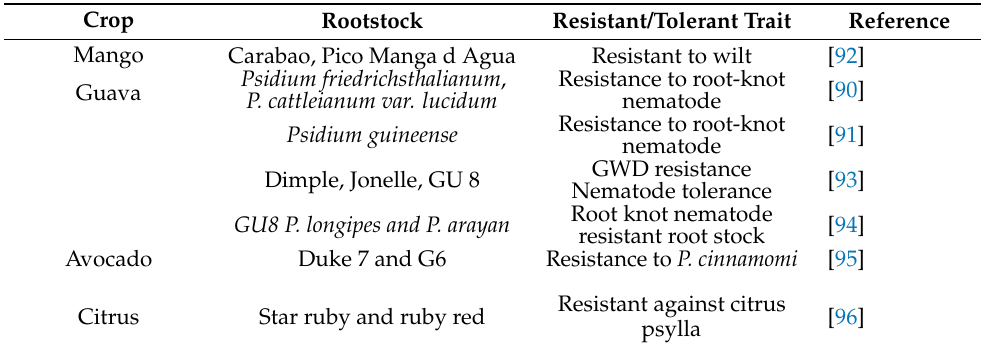
Table 4. Details of rootstock to mitigate biotic stresses in fruit crops. Crop Rootstock Resistant/Tolerant Trait Reference Mango Resistant to wilt [92] Psidium friedrichsthalianum , Resistance to root-knot [90] P. cattleianum var. lucidum nematode Resistance to root-knot Psidium guineense [91] nematode GWD resistance Dimple, Jonelle, GU 8 Nematode tolerance Avocado Duke 7 and